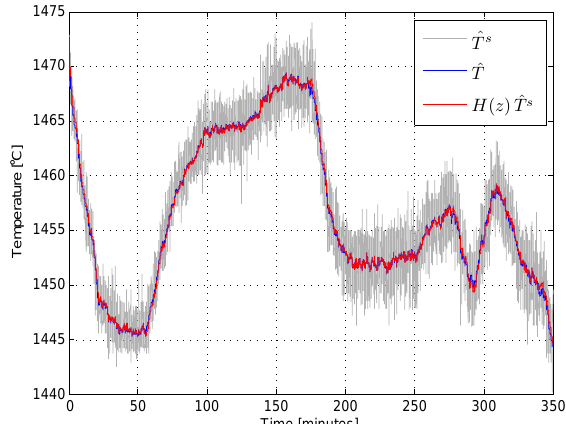
Figure 20: The output of the sensor fusion algorithm, ˆ T , and the lowpass-filtered silicon pyrom- eter, H ( z ) ˆ T s , for cut-off frequency ω c = 2 . 4 10 − 2 ×